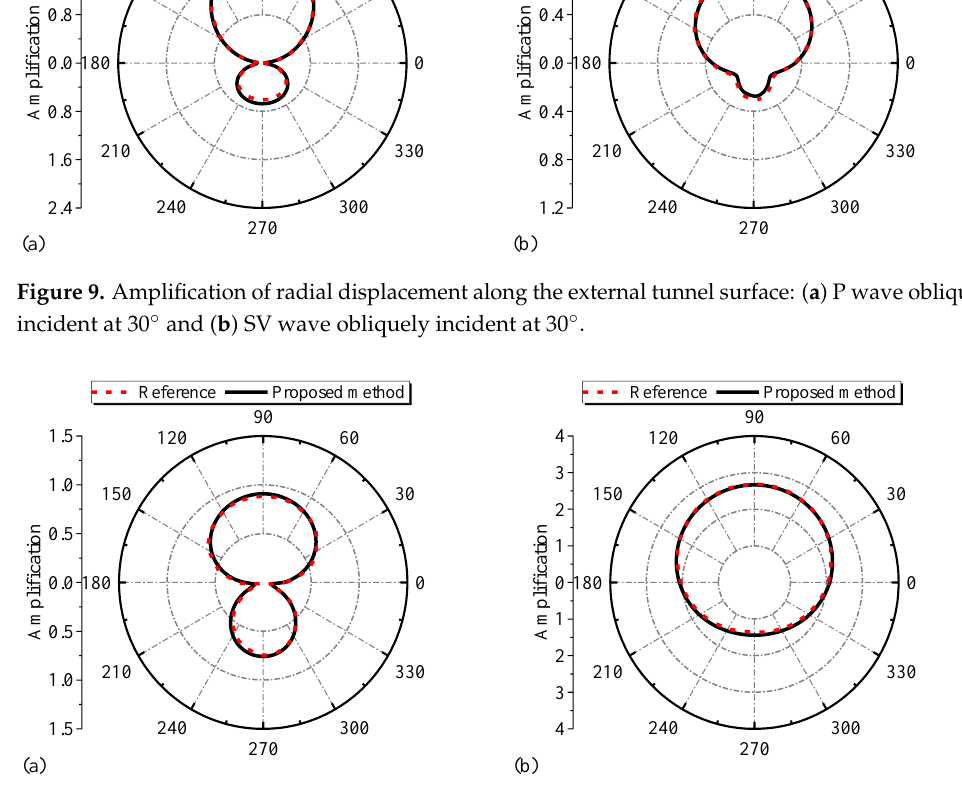
Figure 10. Amplification of axial displacement along the external tunnel surface: ( a ) P wave obliquely incident at 30 ◦ and ( b ) SV wave obliquely incident at 30 ◦ .